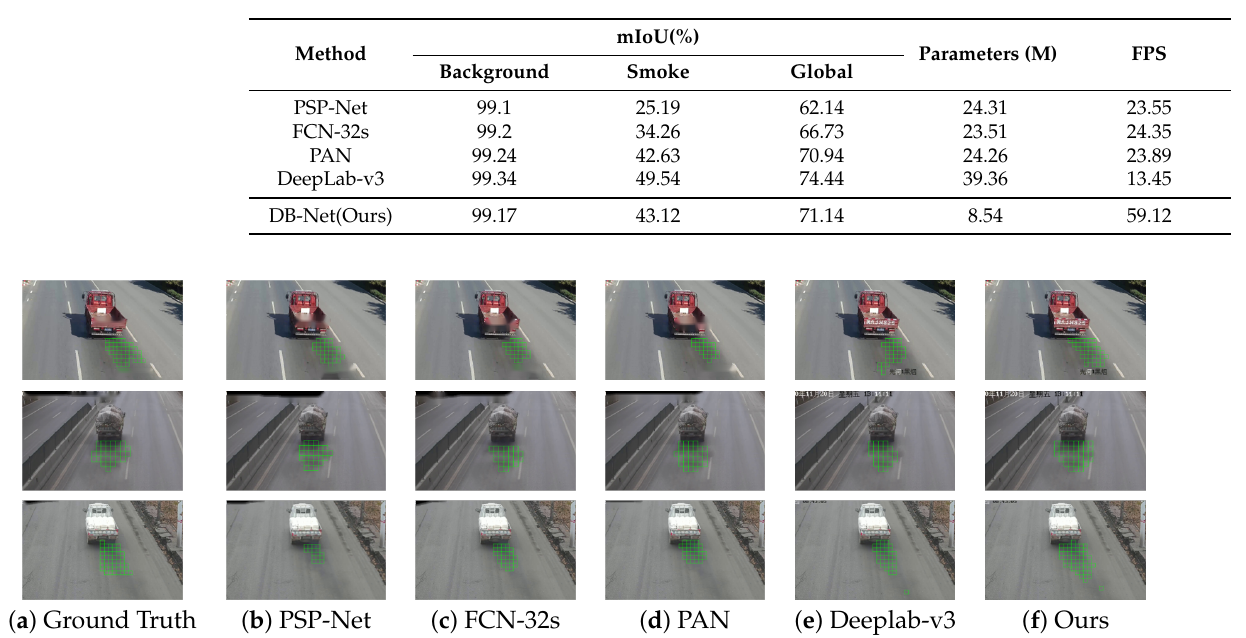
Table 3. Comparison between our method and famous semantic segmentation methods with mIoU in the PoVSSeg test set.